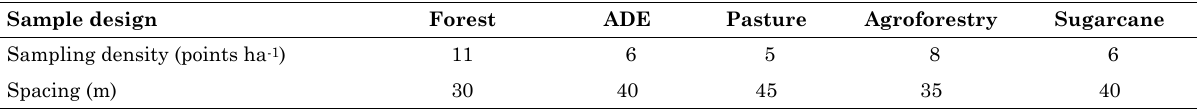
Table 3. Ideal sampling density and spacing based on estimated range from the scaled semivariograms for soil physical properties in the south of